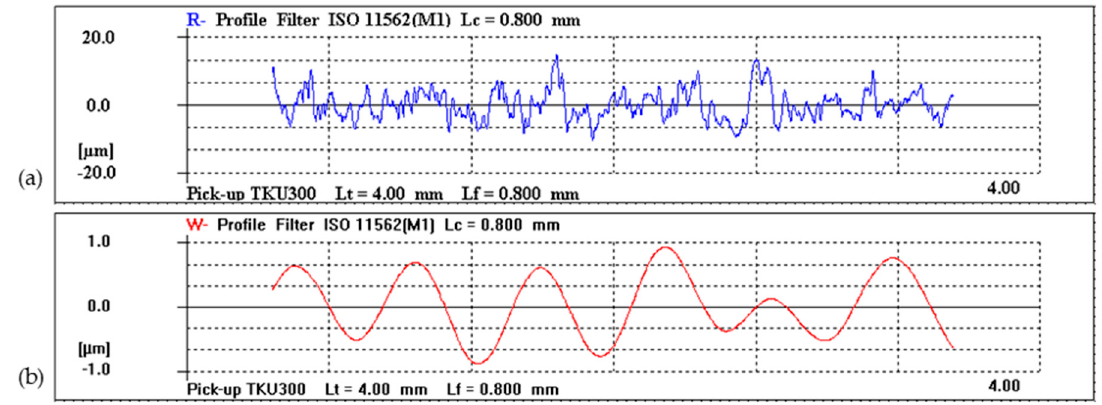
Figure 9. The surface roughness profile ( a ) and the surface waviness profile ( b ), as measured in parallel direction to the wire feed.